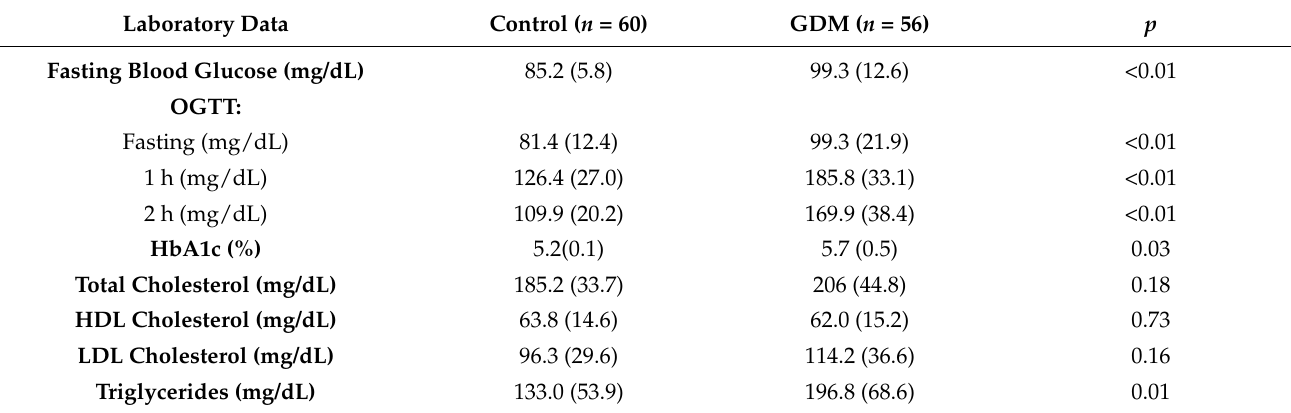
Table 3. Laboratory data obtained in the third trimester of pregnancy of women without and with GDM.